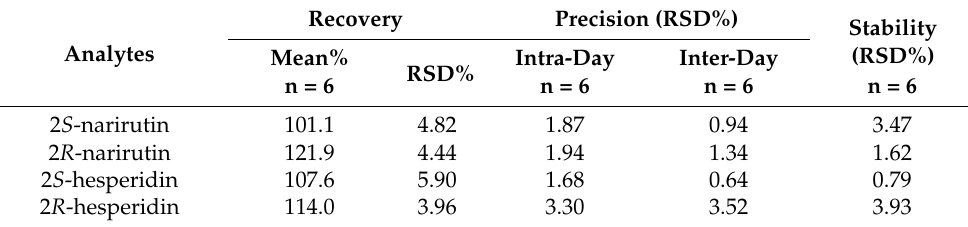
Table 3. The results of the repeatability, stability, recovery and precision of the four analytes in the